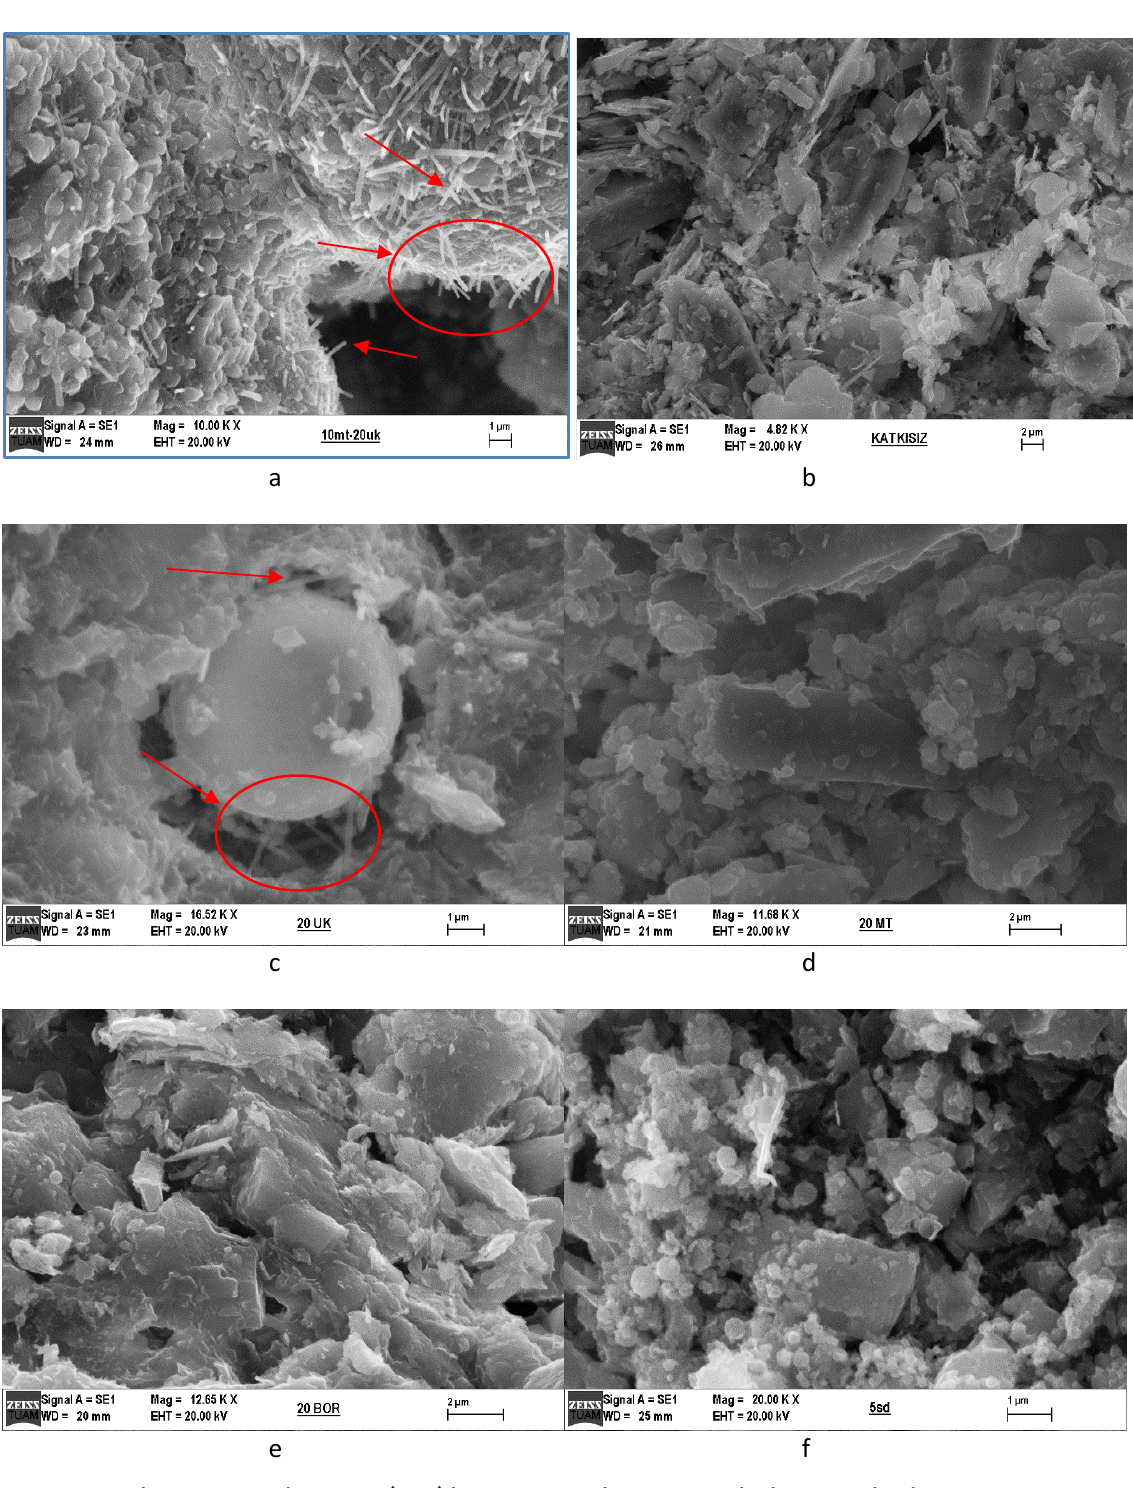
Figure 2. Scanning Electron Microscopy (SEM) images of specimens, -a Ettringite formation in 10MD-20FA specimen. -b No ettringite in SG specimen, -c Ettringite formation in 20FA specimen, -d No ettringite in MD specimen, -e No ettringite in 20BW specimen, -f No ettringite in 5SF